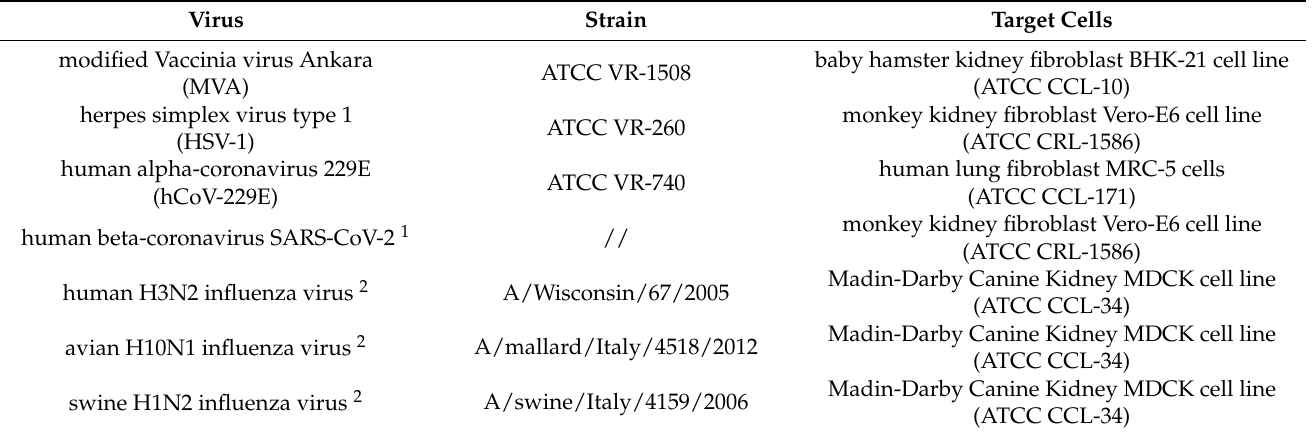
Table 1. Virus trains and target cells used in the